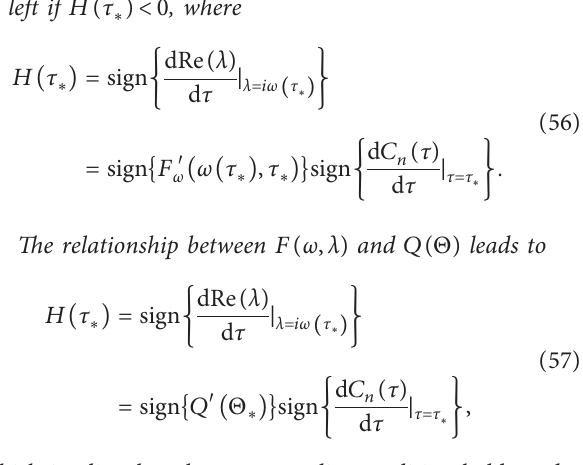
of system (4) when R ∗